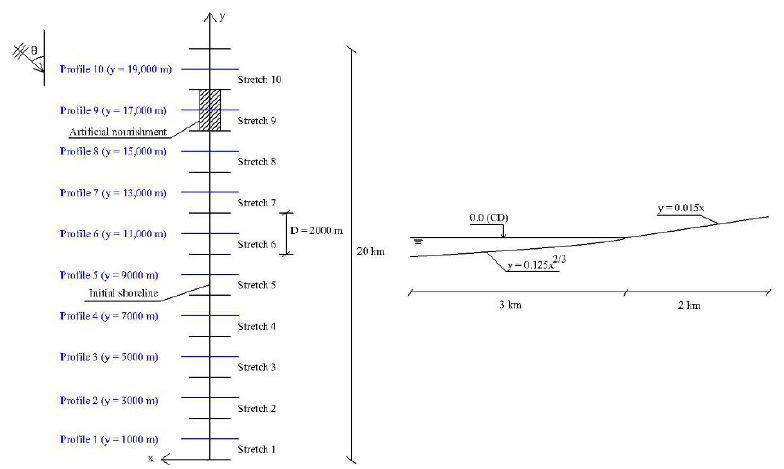
Figure 6. Study area: Plan view ( left ) and cross-shore profile ( right ) (based on [41,42]). Twenty-four wave climate scenarios were generated, considering constant through- out the five years simulation period. These scenarios combined four values of wave heights (H = 1, 2, 3, and 4 m) with 6 different wave directions (θ = 60°, 65°, 70°, 75°, 80°, and